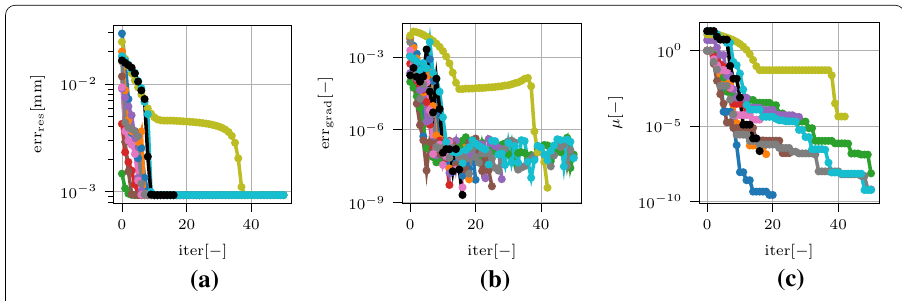
Fig. 7 Development of a residual error err res , b gradient based error err grad and c regularization parameter μ for inverse analysis runs with different initial guesses over iterations, with Gaussian noise with standard deviation σ = 10 − 3 mm added to the measurements